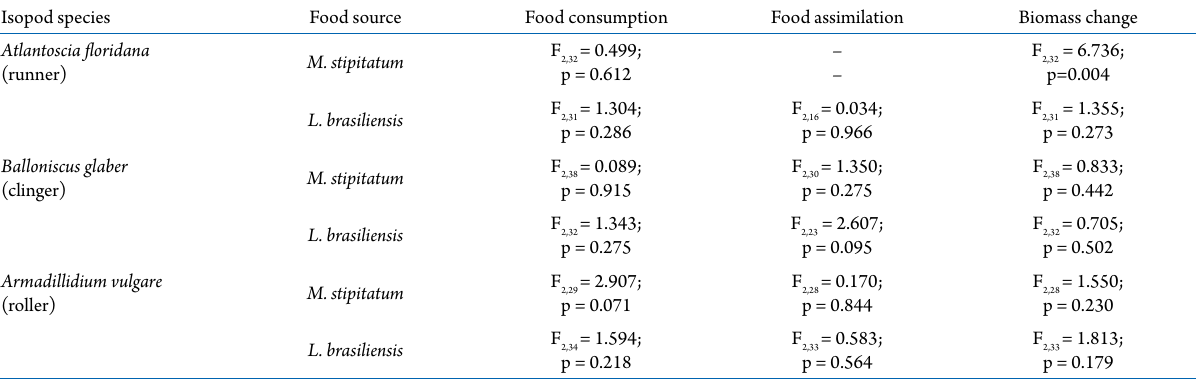
Table 2. Analysis of covariance for feeding parameters of Atlantoscia floridana , Balloniscus glaber and Armadillidium vulgare fed on Machaerium stipitatum and Lithraea brasiliensis .